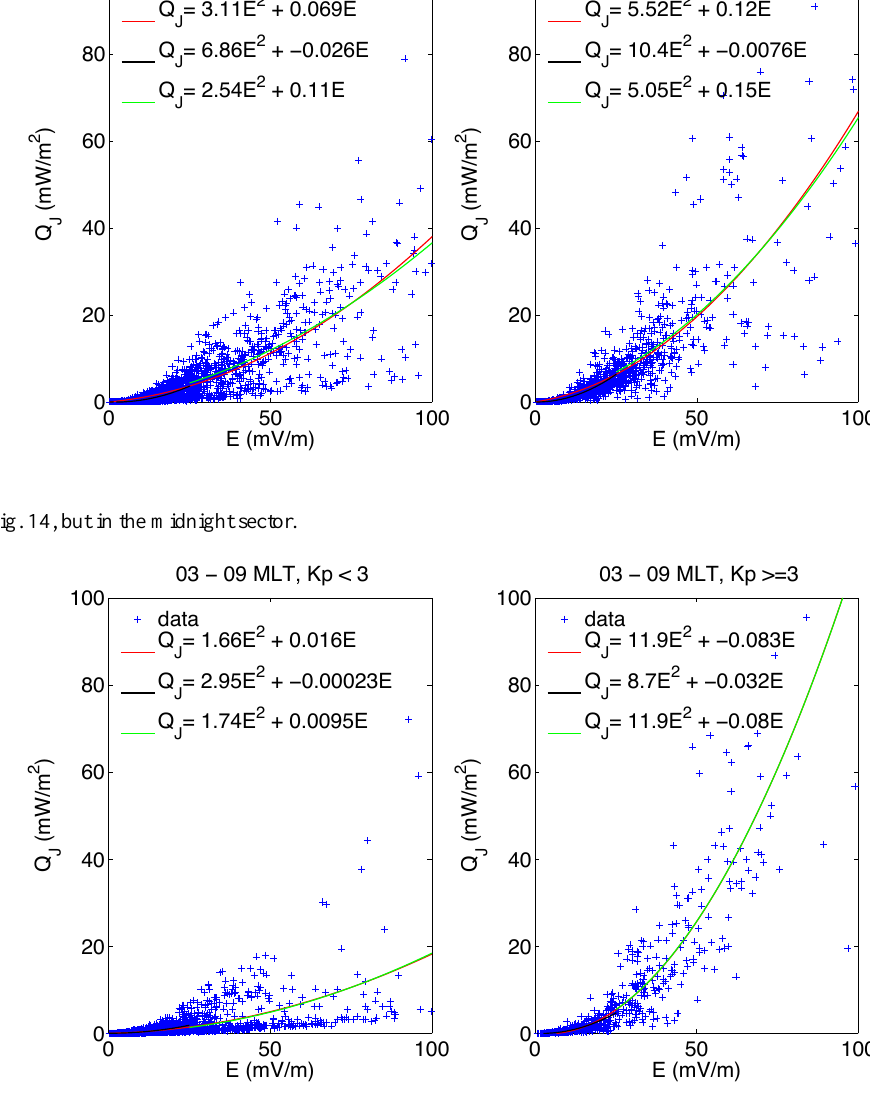
Fig. 17. Same as Fig. 14, but in the morning